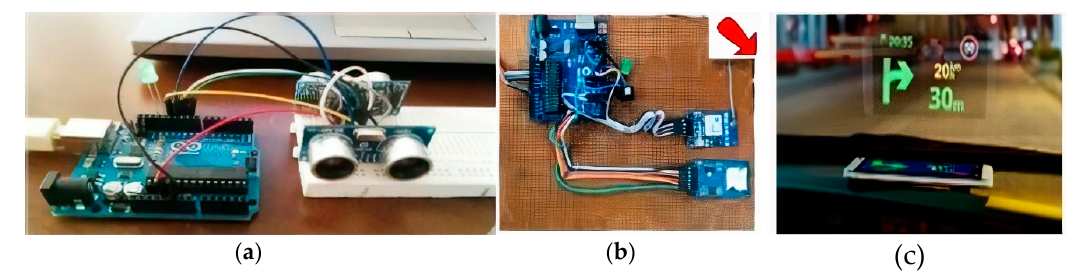
Figure 4. Components used in the road surface monitoring system: ( a ) Arduino with HY-SRF05; ( b ) GPS Receiver; (c) Head-up display module.